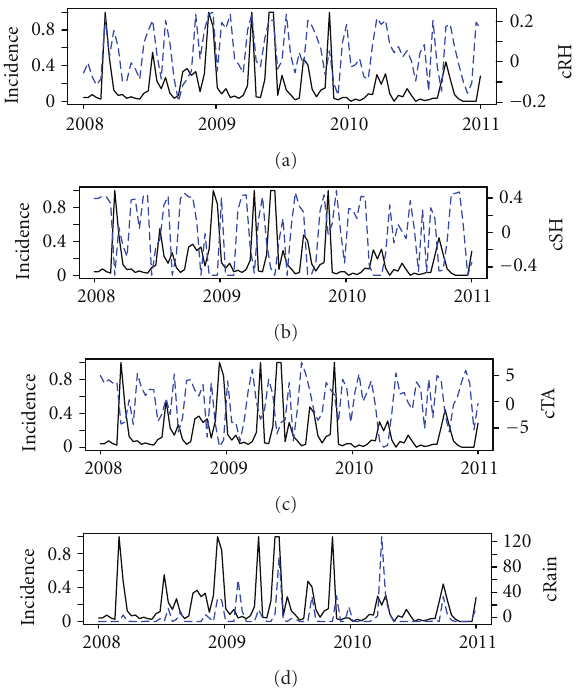
Figure 2: Relative daily incidence of Gibberella zeae spores (contin- uous line) and meteorological variables (dashed lines top to bottom graphs: relative humidity, sunshine hours, temperature amplitude, and rainfall), centered on climatological normal in Passo Fundo during 31-day period starting on September 15th of 2008, 2009, and 2010, respectively. Table 3: Adjusted parameters for the beta